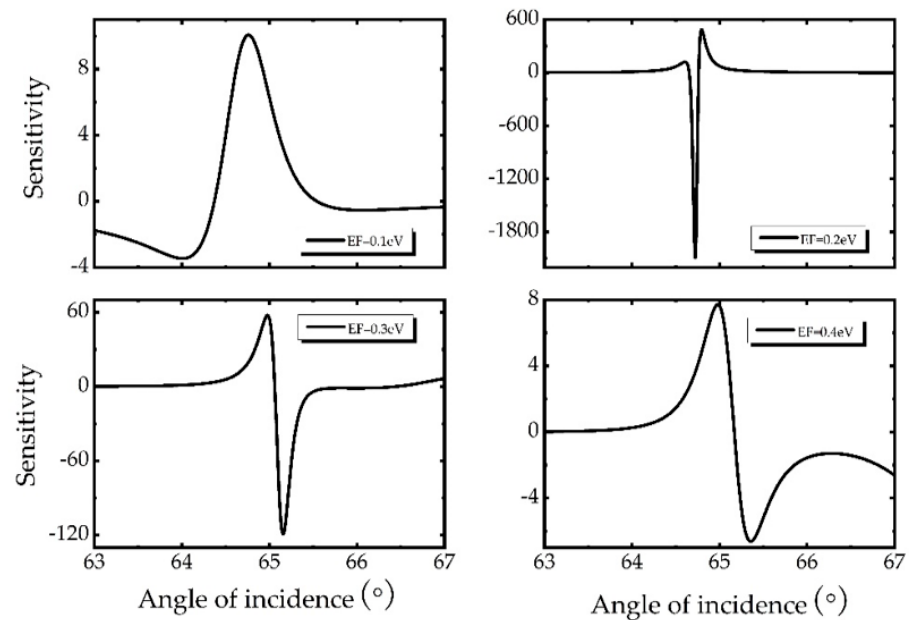
Figure 5. Dependence of sensitivity on Fermi energy, in which Ag thickness d 2 = 15 nm, Au thickness d 3 = 20 nm, hBN thickness d 4 = 131 nm, graphene layer N = 1.